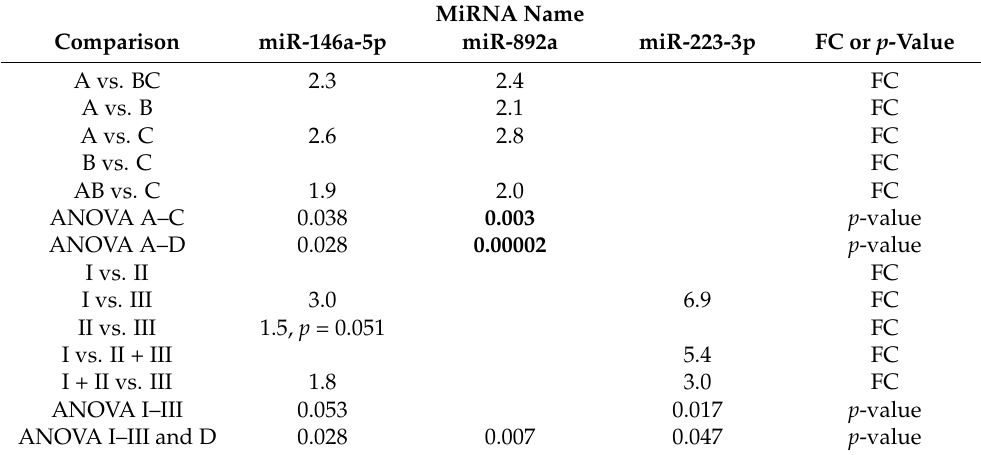
Table 2. Fold changes of differentially expressed miRNAs between prostate cancer groups in qPCR. Table includes only the most significant miRNAs with statistically significant changes in both miR- NAseq analysis and in qPCR validation. Results marked in bold had a higher statistical significance (FDR p < 0.05 to <0.0001) than the rest ( p < 0.05 to <0.0001). Fold change (FC), quantitative polymerase chain reaction